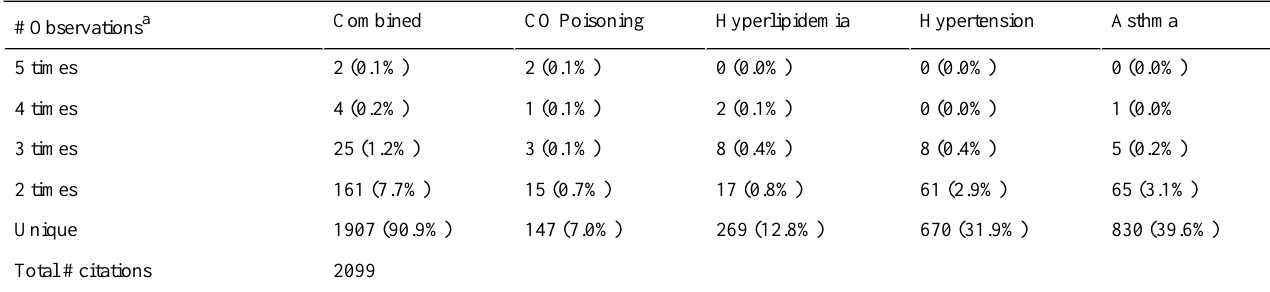
Table 4. Overlap of citations, all topics across all point-of-care products